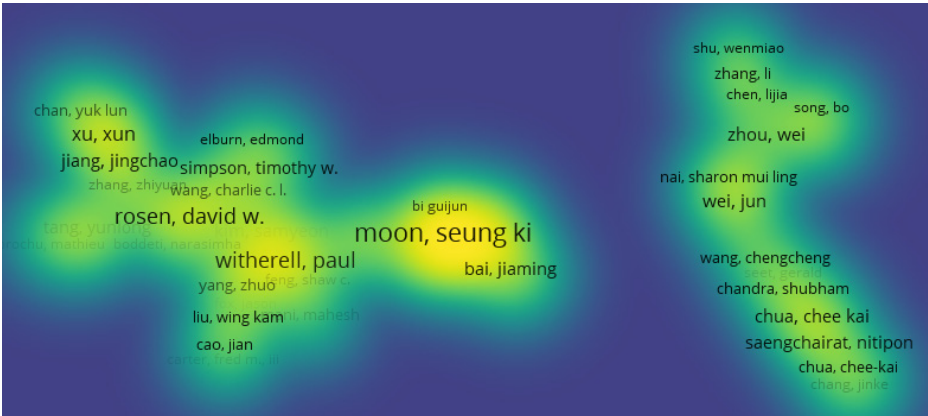
Figure 20. Mapping based on co-authorship showing the density visualization for the first method.